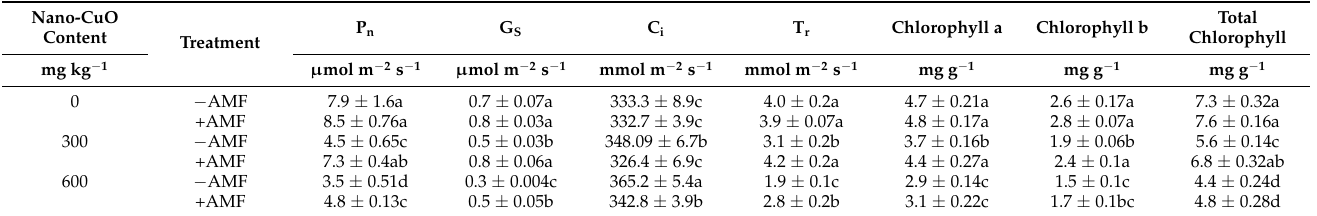
Table 2. Effects of AMF on the photosynthetic parameters and chlorophyll contents of C. indica seedlings under nano-CuO